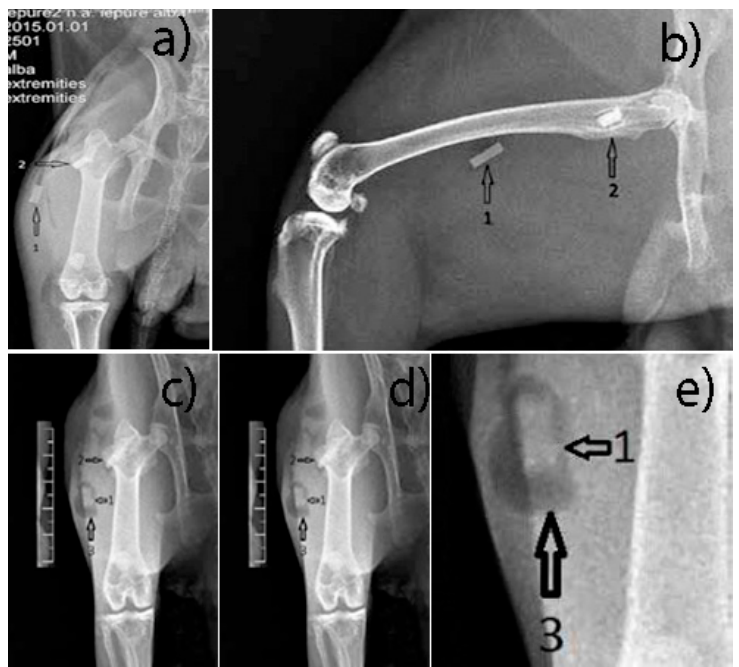
Figure 13. ( a , b ) Post-Operative X-ray, ( c , d , e ) 6 weeks post-operative X ray. 1—parallelepiped implant inserted into the thigh muscles; 2—parallelepiped implant inserted into the bone tissue, greater femoral trochanter; 3—hydrogen bubbles formed around the implant.